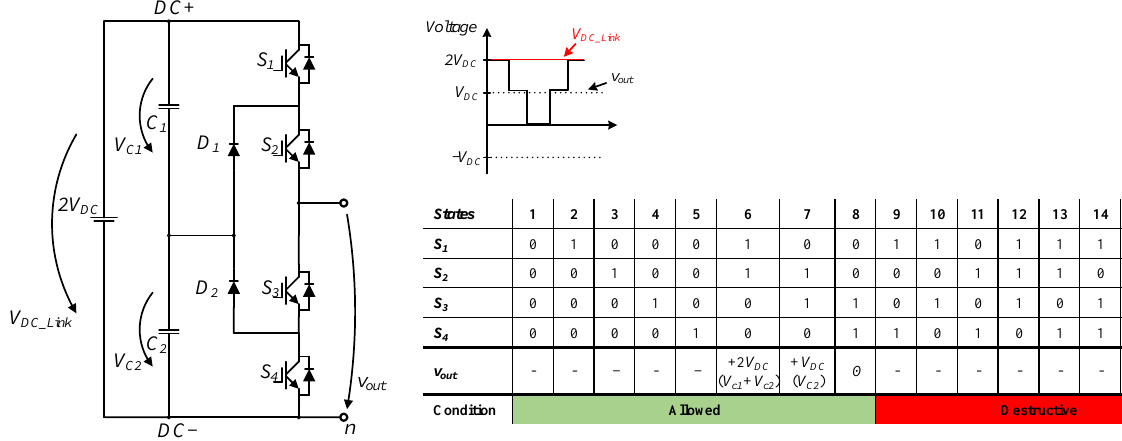
Figure 6. Conventional NPC topology and operation principle.